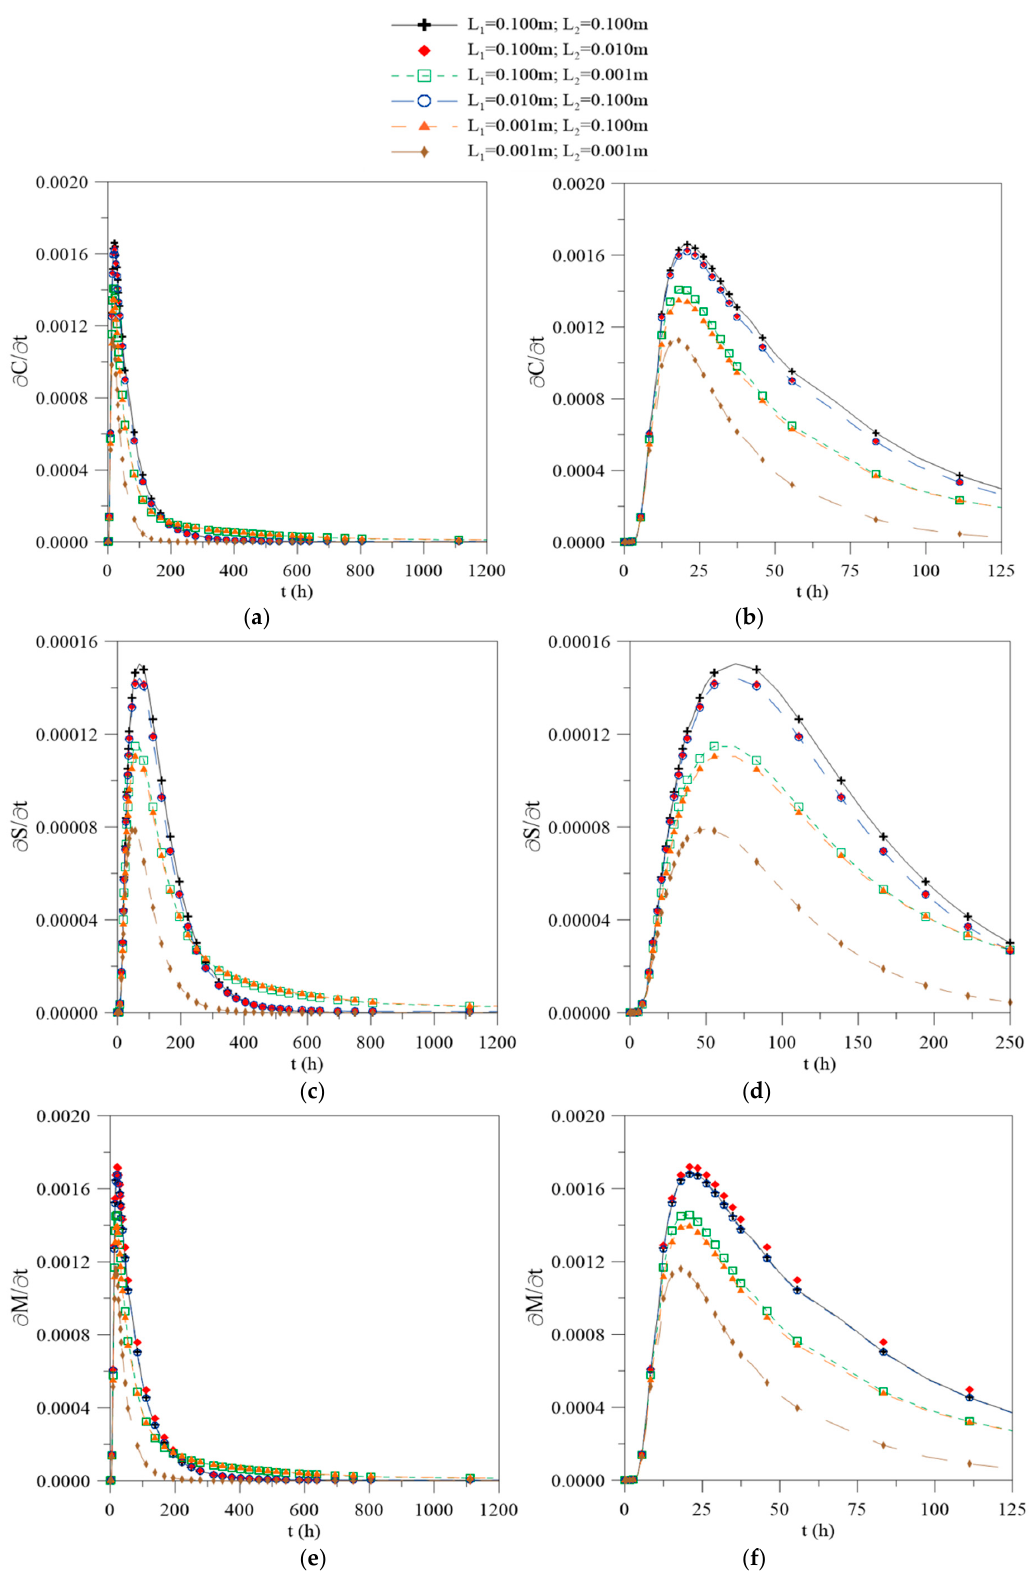
Figure 7. Time variation rate of the ( a ) free water molecules and ( b ) detailed view of ( a ). ( c ) Bound water molecule concentration and ( d ) detailed view of ( b ). ( e ) Local moisture content in the center of the composite and ( f ) detailed view of ( e ).